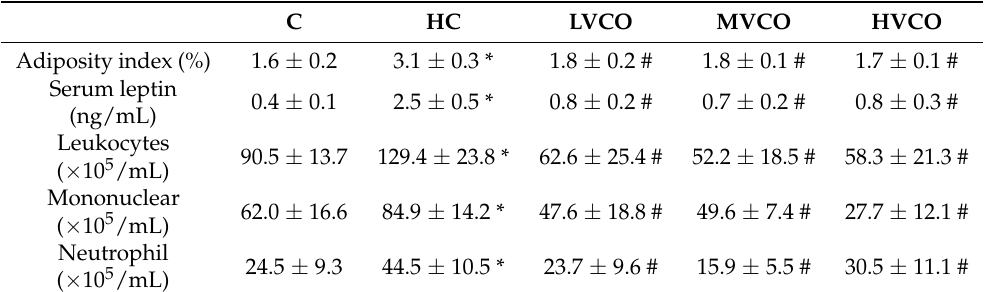
Table 1. Analysis of local and systemic changes in control and obese mice treated with virgin coconut oil.